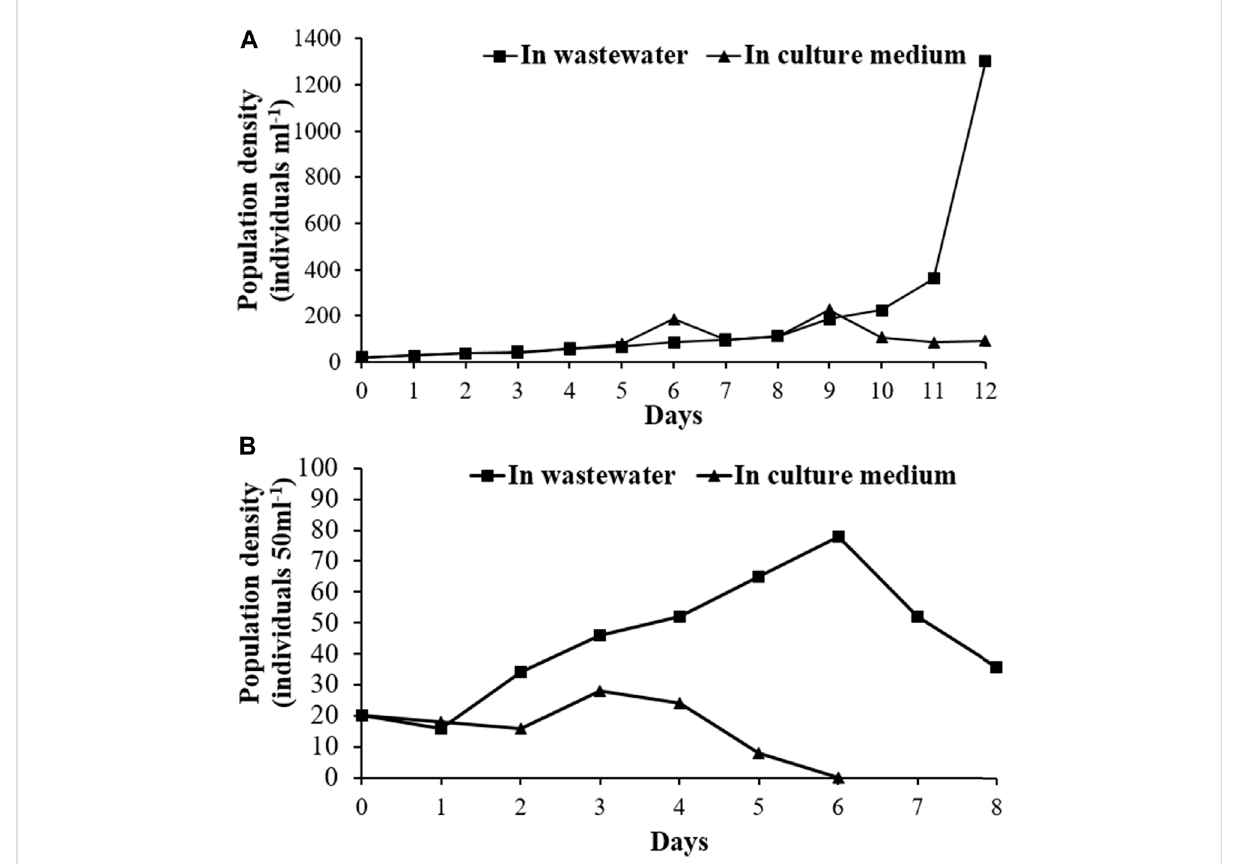
FIGURE 8 Population growth trajectories of (A) B. angularis and (B) M. macrocopa in wastewater and in control with C. vulgaris as